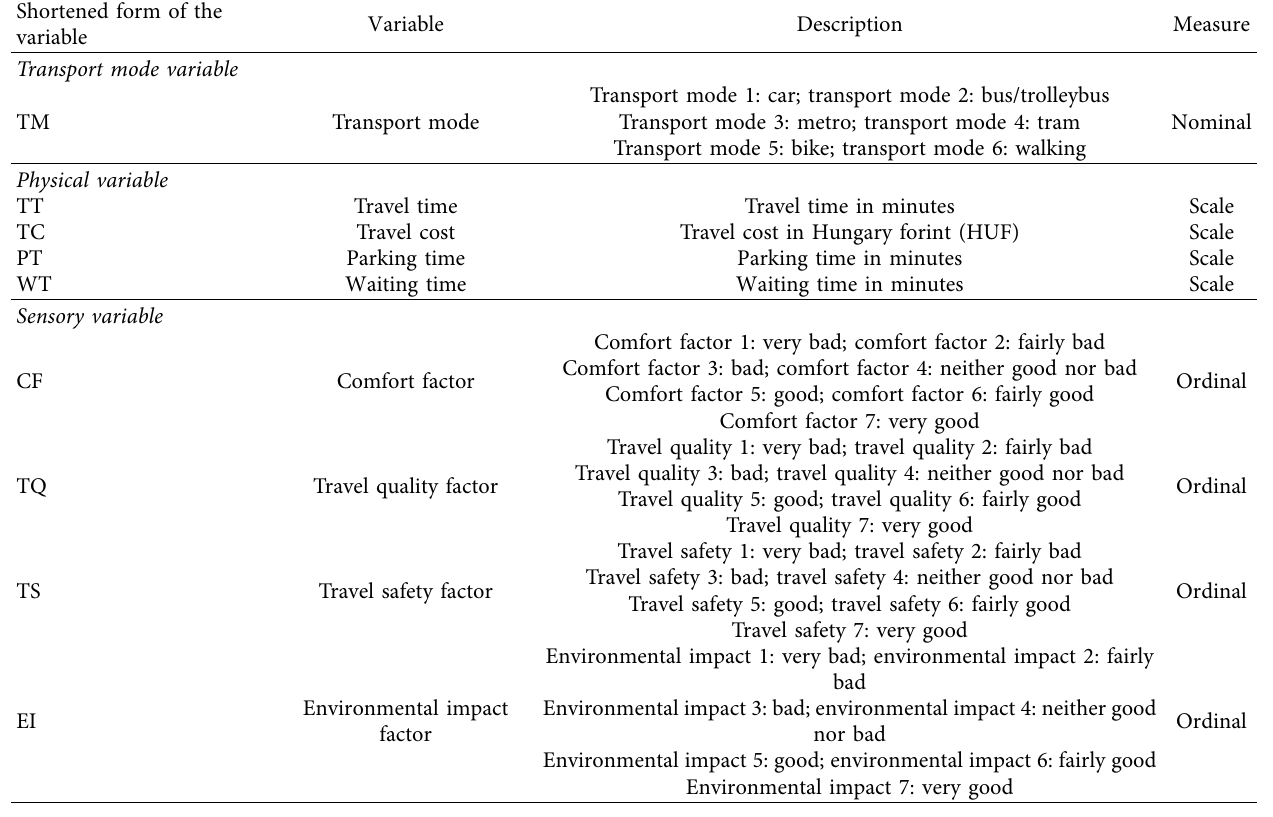
Table 1: The description of the